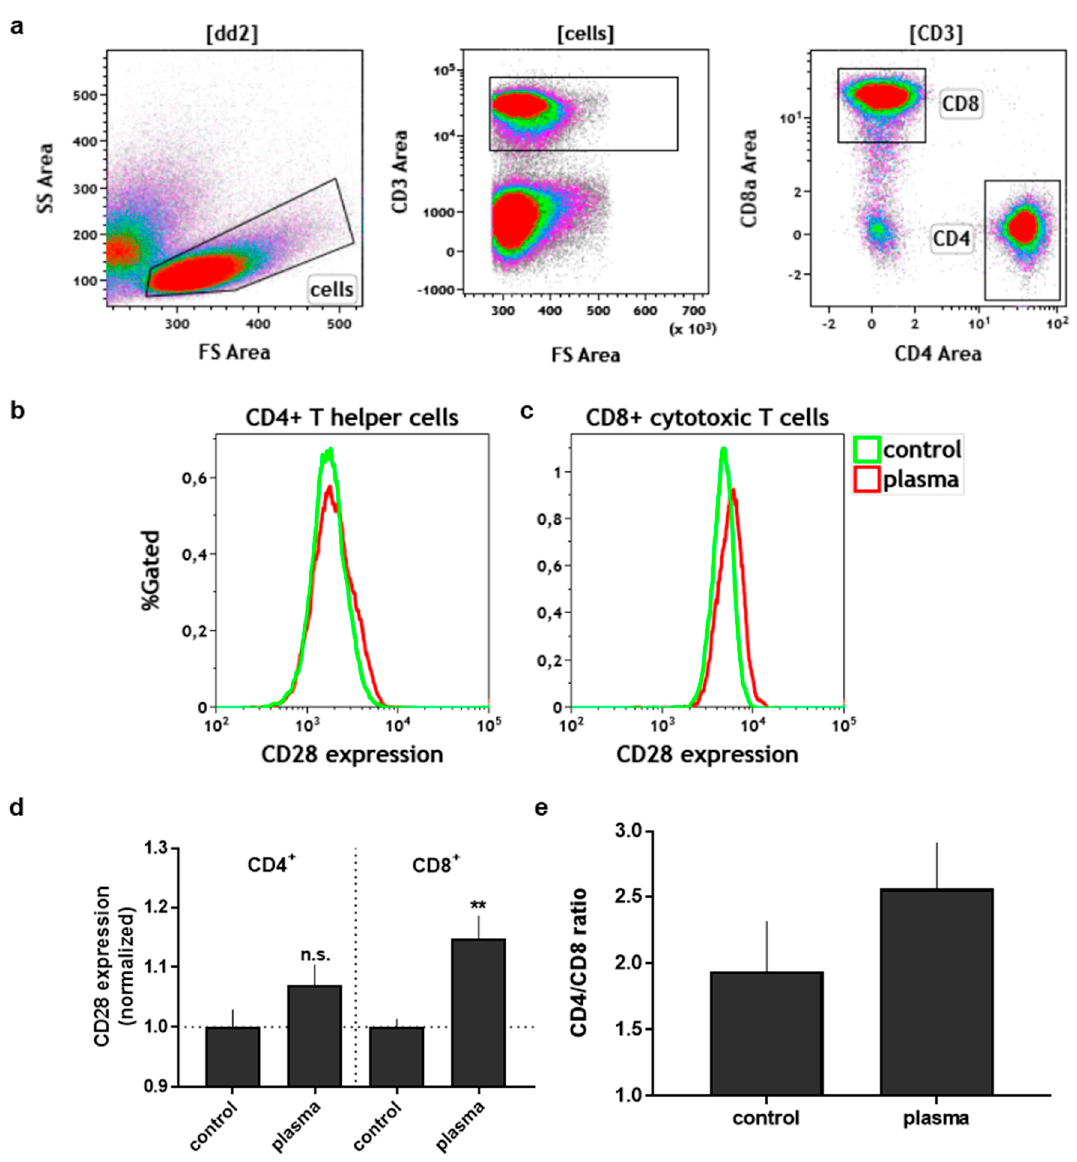
Figure 4. CD28 expression in T lymphocyte splenocyte subpopulations co-cultured with control or plasma-treated melanoma cells. ( a ) Representative flow cytometric dot plots used to gate for two T lymphocyte subpopulations, namely CD4+ T helper and CD8+ cytotoxic T cells; ( b , c ) representative overlay histograms for CD28 marker in expression in CD4+ and CD8+ cells, respectively; ( d ) fold change quantification of CD28 expression in T cells co-cultured for 24 h with either control or plasma-treated melanoma cells; ( e ) CD4/CD8 of T cells co-cultured for 24 h with either control or plasma-treated melanoma cells. Data are mean + S.E. of several spleens, statistical analysis was performed using t